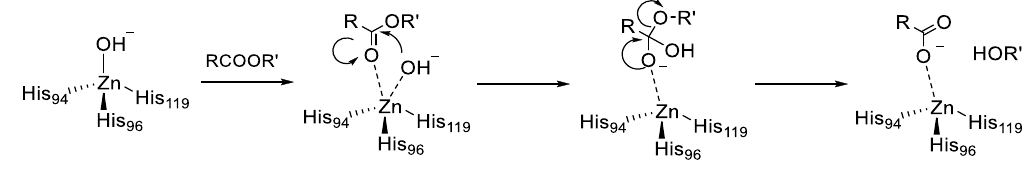
Figure 2. Esterase Activity of carbonic anhydrases (CAs).